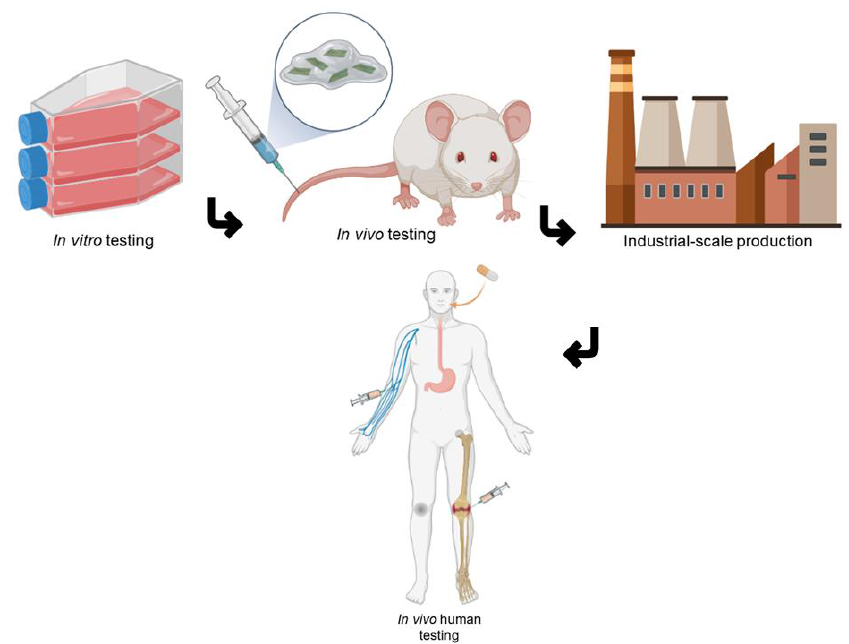
Figure 8. Brief schematic illustration of the steps and challenges of incorporating 2DnMat into systems for biomedical applications. Firstly, in vitro testing to infer on the biocompatibility of the nanomaterials and their interaction with cells must be conducted. The second logical step is to proceed to in vivo testing and evaluate the biocompatibility and therapeutic effects on live models. The ability to mass produce the nanomaterials is imperative for their commercialization and large- scale use. Lastly, human testing is crucial for the evaluation of the nanomaterials therapeutic effect and its safety on humans. Created in